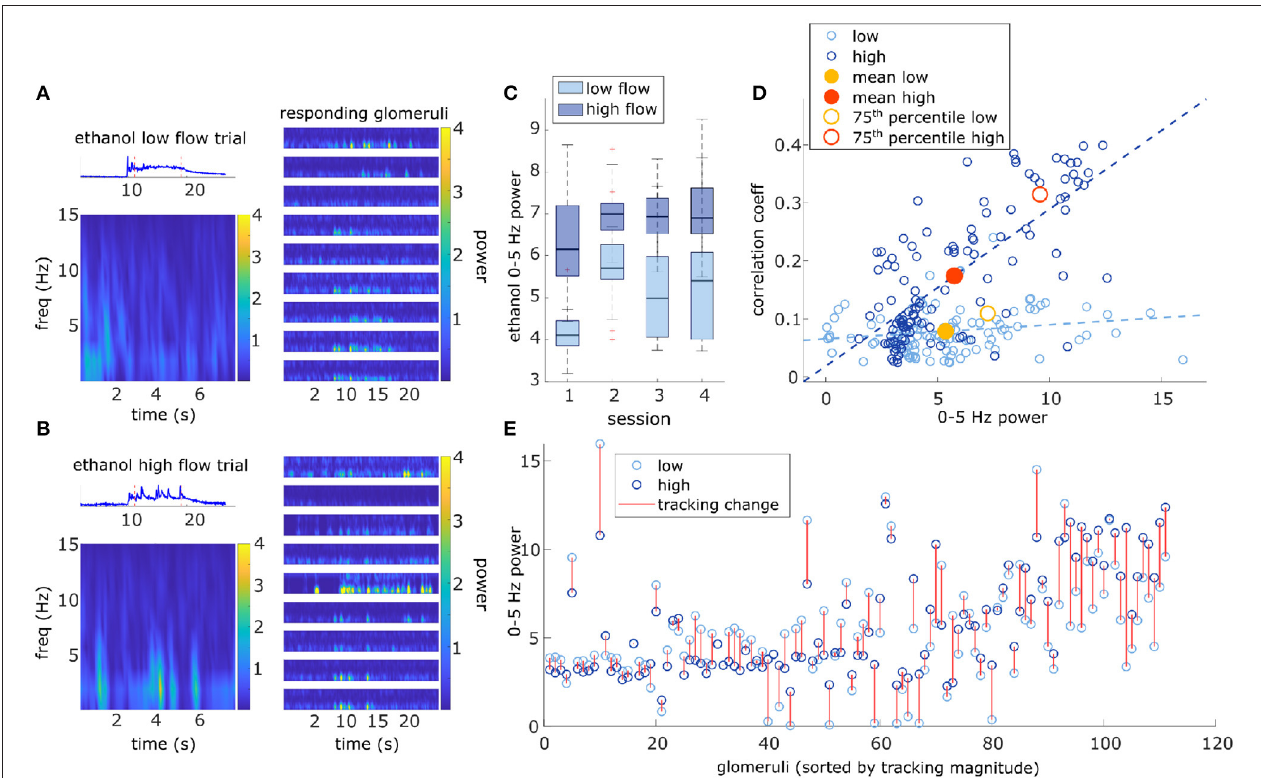
FIGURE 7 | Higher magnitude of glomerular response power (0–5 Hz) is associated with higher correlation with plume dynamics. (A) Ethanol signal from a single low flow trial is plotted (top-left) and a corresponding Short-time Fourier transform (STFT) of the plume (time between red dotted lines) is shown below (bottom-left). STFTs are also shown for a sample of glomeruli responding to the plume (right). STFTs show most response power of the glomeruli and odor signal is concentrated between 0 and 5 Hz. Glomeruli STFTs are sorted (top to bottom) by increasing correlation with plume dynamics. (B) Same as (A) but for a single high flow trial from another example FOV. (C) Box plots for the distributions of stimulus power (0–5 Hz) for all trials within the demarcated flow condition are plotted for each session. On average, high flow distribution means (dark blue) significantly exceeded low flow distribution means (light blue) [ t (116) = 31, p < 0.001]. (D) Within both high and low flow conditions, tracking (correlation magnitude of glomerular responses with plume dynamics) is plotted against response power (0–5 Hz power spectrum change between “odor off” and “odor on” periods) for each glomerulus (blue hues, circles). Glomeruli with stronger tracking have a greater increase in response power during plume presentations ( r = 0.74, p < 0.001). When calculated within flow, this relationship is significant within high flow ( r = 0.73, p < 0.001), but not within low flow ( r = 0.19, p = 0.05). The average response across all glomeruli is plotted (low average = yellow dot, high average = red dot) to represent the population response. Mean response power of the glomerular population is not significantly different between low and high flow, except for when calculated with glomeruli whose mean activity is in the 75th percentile (low average = yellow circle, high average = red circle). (E) Response power of each glomerulus is again plotted, but the change within a glomerulus between low flow (light blue) and high flow (dark blue) is signified by the red line. Glomeruli are plotted sequentially along the x-axis and are sorted left to right by increasing tracking ability. As tracking ability increases, so does the change in response power between flow conditions. This is consistent with the significant change in mean response between flow condition observed in the 75th percentile [plotted as red/yellow circles in (D)